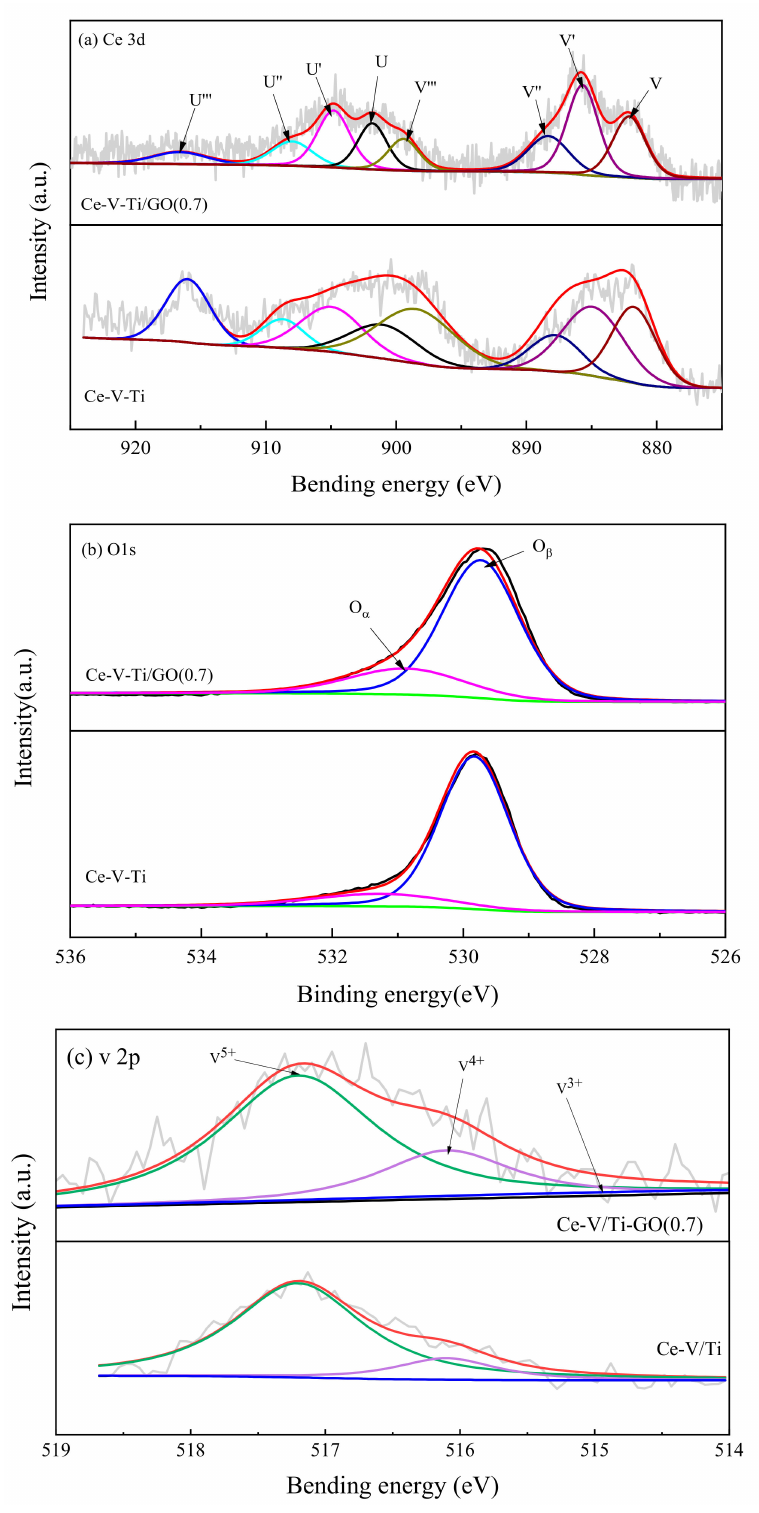
Figure 8. XPS spectra for: Ce 3d ( a ), O 1s ( b ), and V 2p ( c ) of the